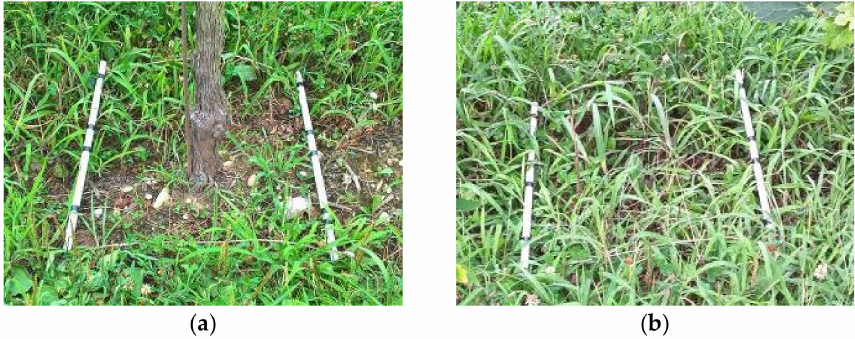
Figure 3. The frames used for measurements: ( a ) Around a vine; ( b ) between two